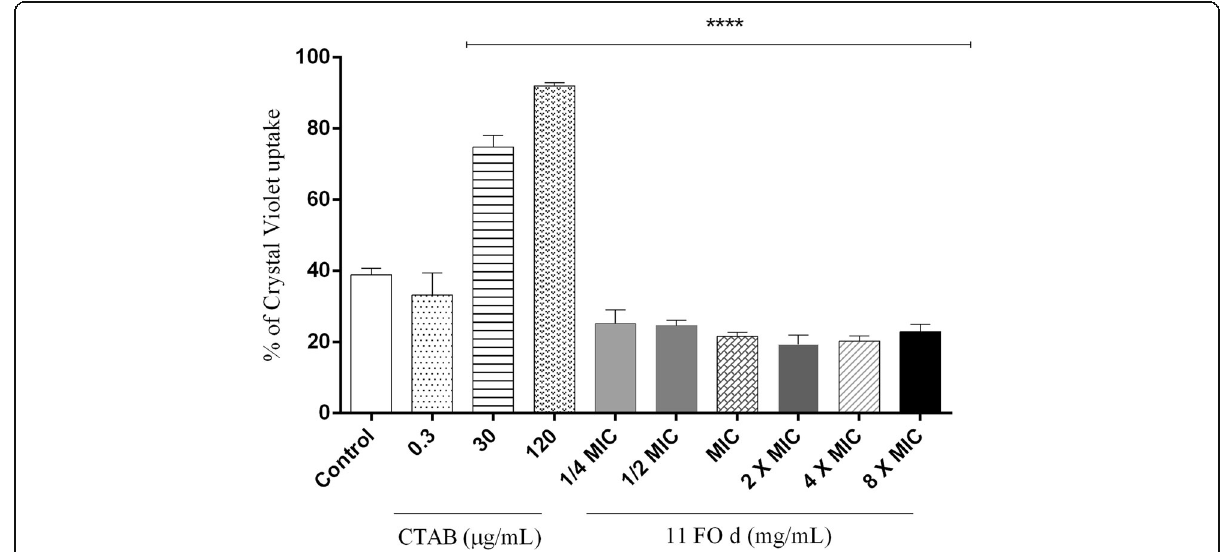
Fig. 6 Measurement of cell permeability. Bacterial cells were incubated in PBS (control) or in PBS containing different concentrations of CTAB or 11FO d and were then exposed to 10 μ g/mL crystal violet for 10 min. The culture supernatant was collected for an absorbance reading at 590